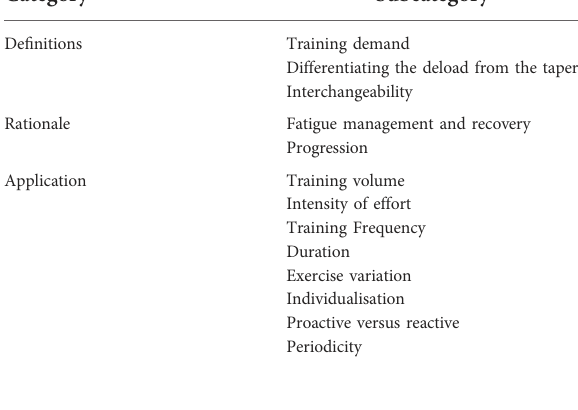
TABLE 2 Summary of categories and